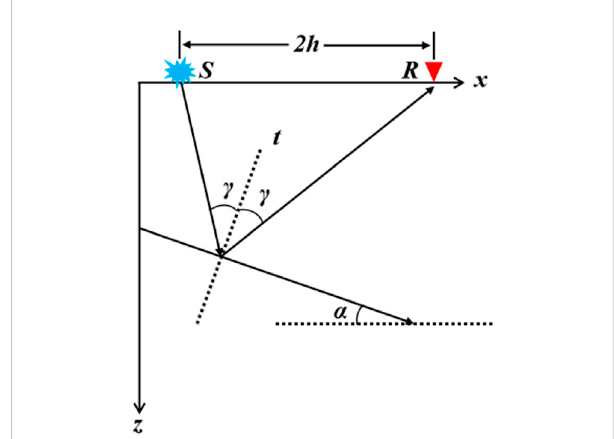
FIGURE 2 Re fl ection ray paths in a normal velocity medium. a is the inclination of the re fl ector and γ is the angle of the ray normal to the re fl ector. S and R are the position of the wave fi eld continued to the local source and receiver points in the subsurface respectively. h is the local subsurface half offset after the downward continuation. z and x are the depth and vertical position of the re fl ection point, respectively.